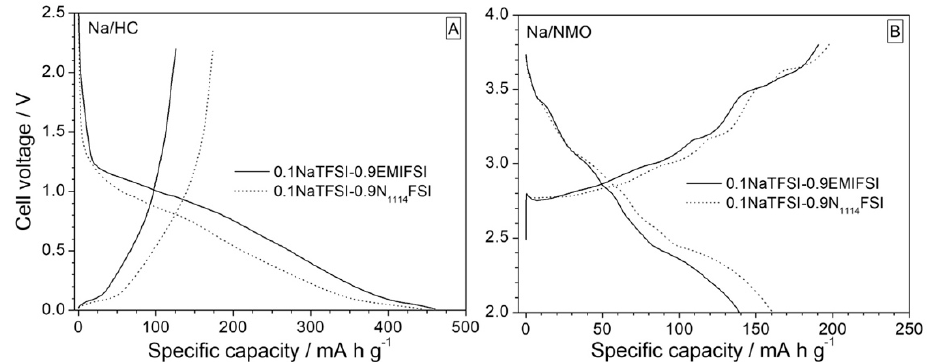
Figure 6. Voltage-capacity profile related to the first charge-discharge cycle of Na/HC (panel ( A )) and Na/NMO (panel ( B )) cells containing the 0.1NaTFSI-0.9EMIFSI (solid traces) and 0.1NaTFSI-0.9N electrolytes. Current rate: 0.1C. Temperature: 20 °C. The voltage values are based on the Na + /Na° redox couple.